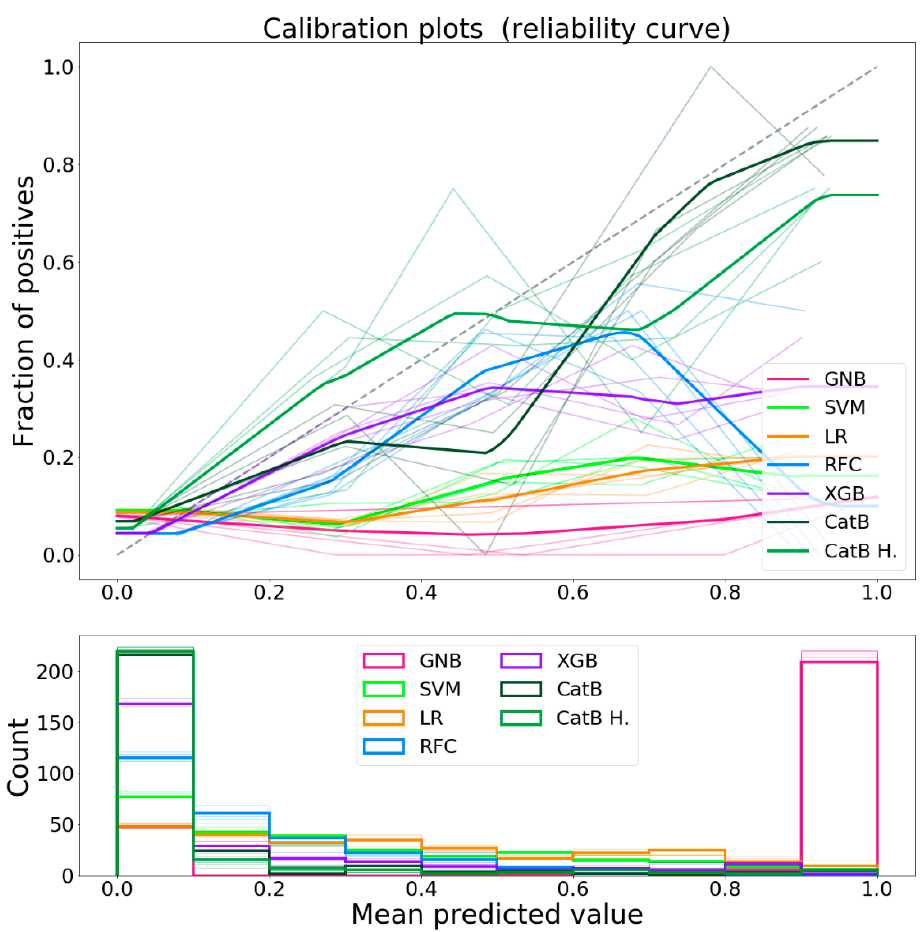
Figure 6. Calibration curves of the classifiers. Table 4. Results of the TAVI mortality prediction model and comparison with other classifiers.